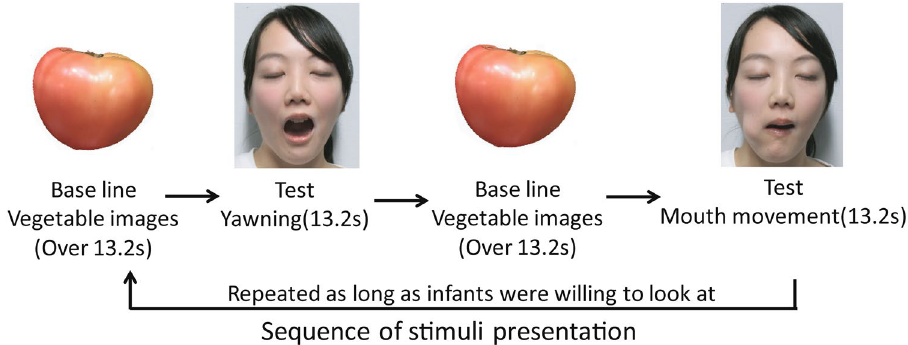
Figure 4. The timeline of the stimulus presentation. In each trial, images of five kinds of vegetables were presented during the baseline period for at least 13.2 s. In the test period, yawning or mouth movements were presented for 13.2 s. The presentation order of yawning and mouth movement in test period was counterbalanced across